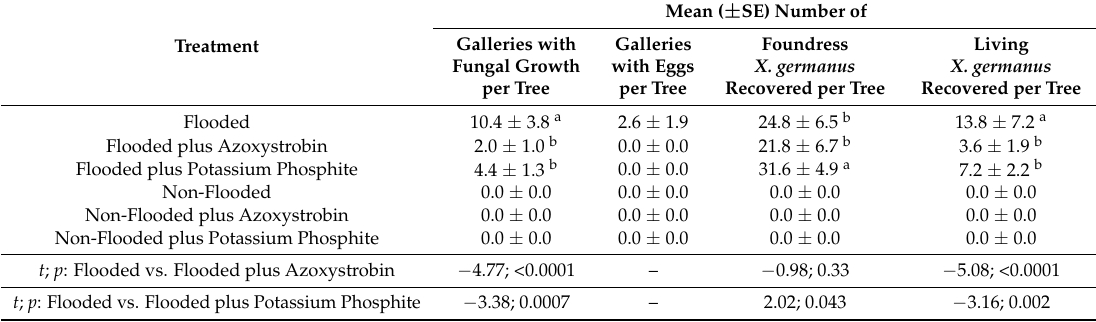
Table 2. Influence of flooding and preventive fungicide treatment on attacks and colonization success of ambrosia beetles in C. canadensis deployed in Ohio.